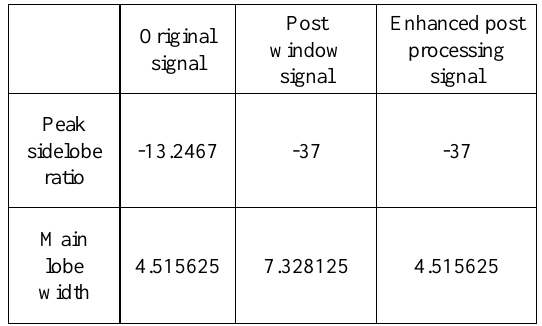
processing algorithm